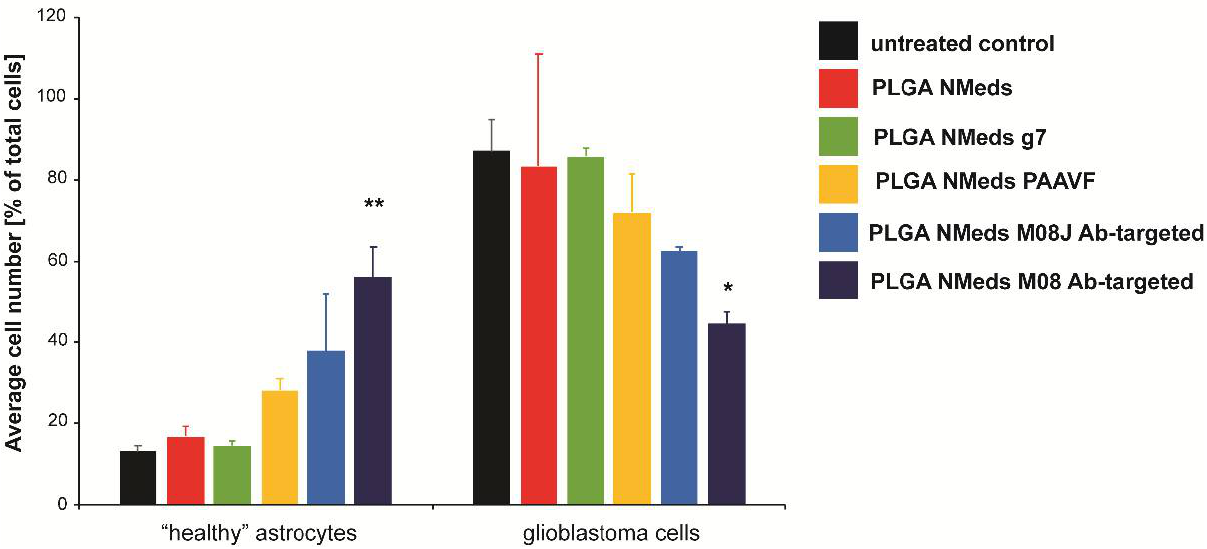
Figure 5. The confocal microscopy quantification ofC6 and DI TNC1 cell numbers per optic field of view (OFV) after a 3 h incubation with 50 μg/mL of NMeds modified with 10 μg of ligand. All experiments were performed in triplicate ( n = 3), and the number of cells visualised by DAPI and Calcein-AM staining per OFV was measured by counting 8 OFV for each condition. Statistical analysis was performed with one-way ANOVA, * p < 0.05, ** p < 0.01.